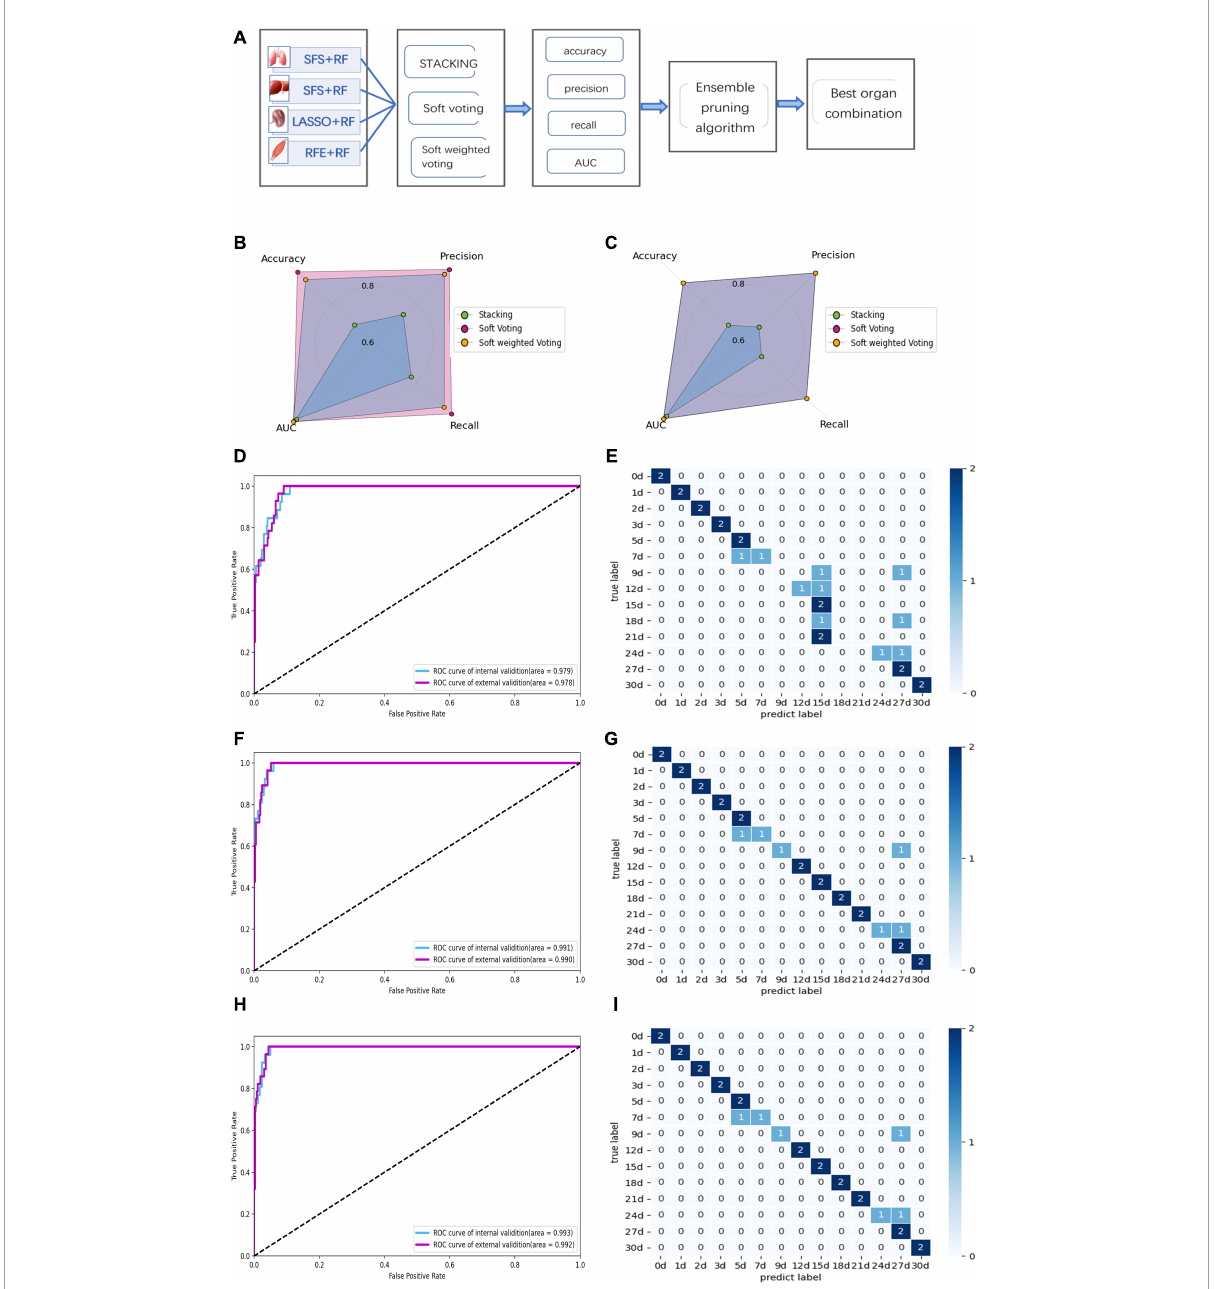
FIGURE7 Performance of multi-organ fusion strategy to predict PMI. (A) Framework of multi-organ fusion strategy to predict PMI. (B) Accuracy, precision, recall, and AUC of internal validation for stacking are 0.692, 0.740, 0.774, and 0.979, respectively. Accuracy, precision, recall, and AUC of internal validation for soft voting are 0.962, 0.964, 0.964, and 0.991, respectively. Accuracy, precision, recall, and AUC of internal validation for soft-weighted voting are 0.923, 0.94, 0.929, and 0.993, respectively. (C) Accuracy, precision, recall, and AUC of external validation for stacking are 0.679, 0.668, 0.679, and 0.978, respectively. Accuracy, precision, recall and AUC of external validation for soft voting are 0.893, 0.94, 0.893, and 0.99, respectively. Accuracy, precision, recall, and AUC of external validation for soft-weighted voting are 0.893, 0.94, 0.893, and 0.992, respectively. (D) The ROC curve of internal and external validation for the stacking model based on multi-organ fusion strategy. (E) The confusion matrix of external validation for the stacking model, the mispredictions occurred 7 to 12 days and 18 to 24 days after death. (F) The ROC curve of internal and external validation for the soft voting model based on multi-organ fusion strategy. (G) The confusion matrix of external validation for the soft voting model. The external validation samples were predicted incorrectly at 7, 9, and 24 days of PMI. (H) The ROC curve of internal and external validation for the soft-weighted voting model based on multi-organ fusion strategy. (I) The confusion matrix of external validation for the soft-weighted voting model. The samples were mispredicted at 7, 9, and 24